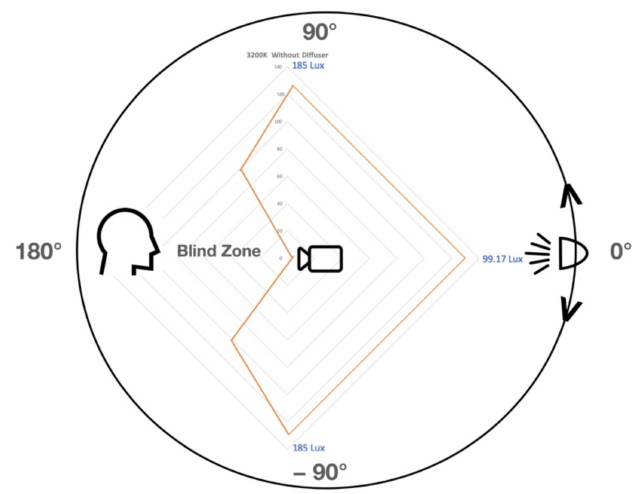
Figure 14. Compare the required light intensity (Lux) for facial recognition of 3200 K light source without diffuser from front, right, and left side for a fixed distance of detection of 130 cm.